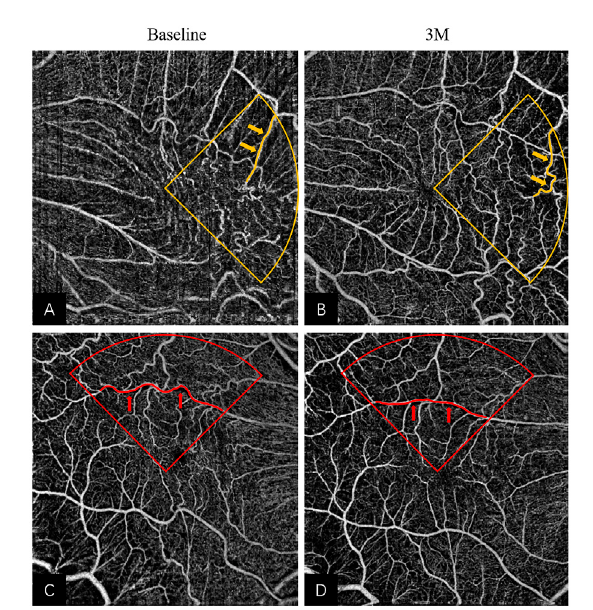
FIGURE 4 Remodeling of super fi cial retinal layer vessels in eyes underwent iERM surgery: (A,B) The pre- and post-operative OCTA images of a 65-year-old woman; more tortuous vessels (highlighted in yellow) were observed in the temporal quadrant at 3M in Figure 3B. (C,D) The pre- and post-operative OCTA images of a 57-year-old man; more linear vessels (highlighted in red) were observed in the superior quadrant at 3M in Figure 3D. Abbreviations: iERM, idiopathic epiretinal membrane; OCTA, optical coherence tomography